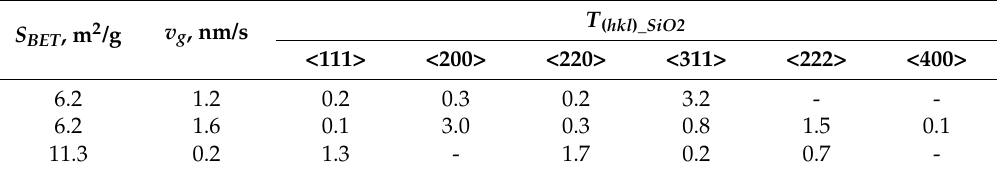
Table 1. Texture coefficients of SDC thin films deposited by evaporating powders of different specific surface area on SiO 2 substrates at 600 ◦ C ( v g —deposition